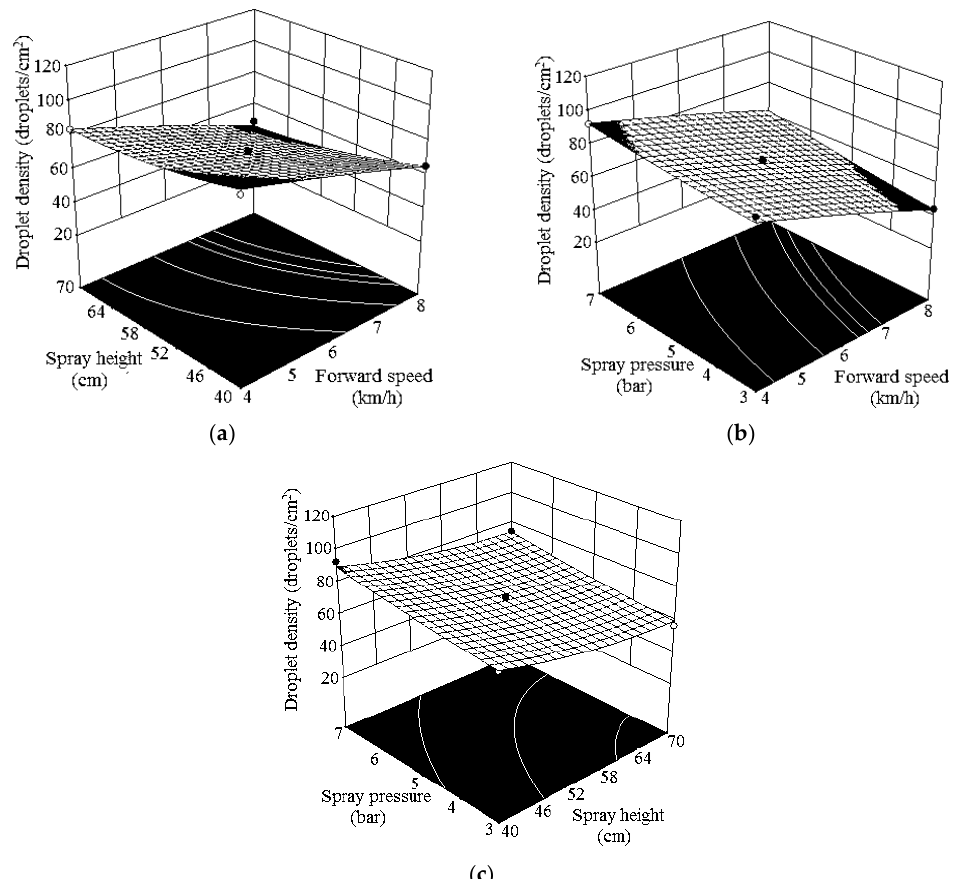
Figure 10. Three-dimensional surface map for droplet density: ( a ) interaction effect of forward speed and spray height at 5 bar pressure; ( b ) interaction effect of forward speed and spray pressure at 55 cm height; ( c ) interaction effect of spray height and spray pressure at 6 km/h